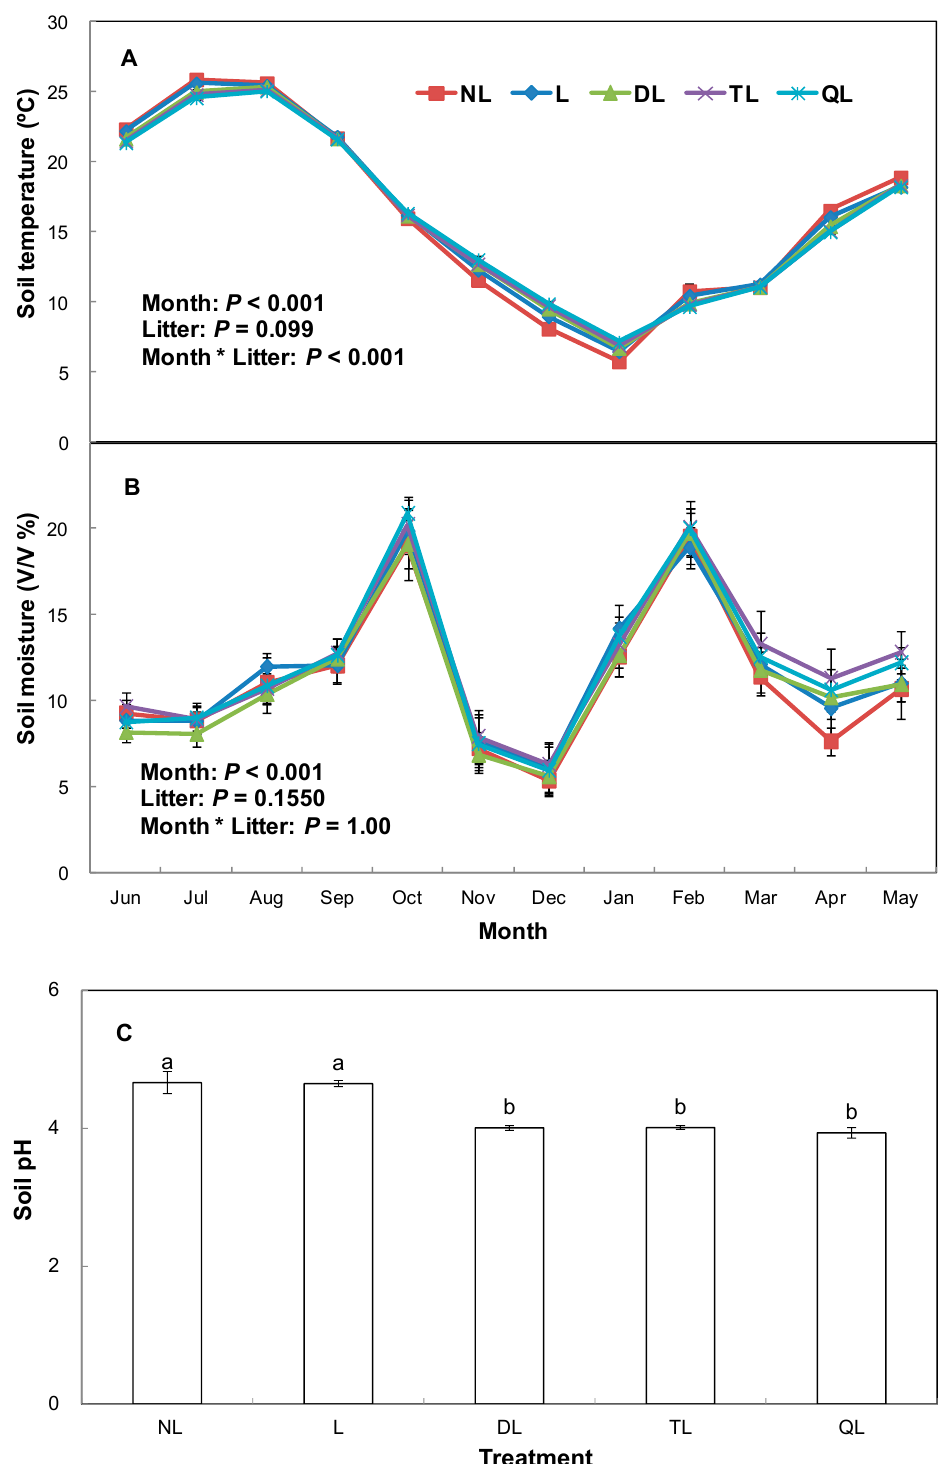
Figure 1. Effects of litter quantity on soil temperature ( A ), moisture ( B ), and pH ( C ). Different letters indicate significant differences between treatments at p < 0.05. Values are presented as the means ± standard error. NL: no litter input; L: natural litter; DL: double litter; TL: triple litter; QL: quadruple litter.